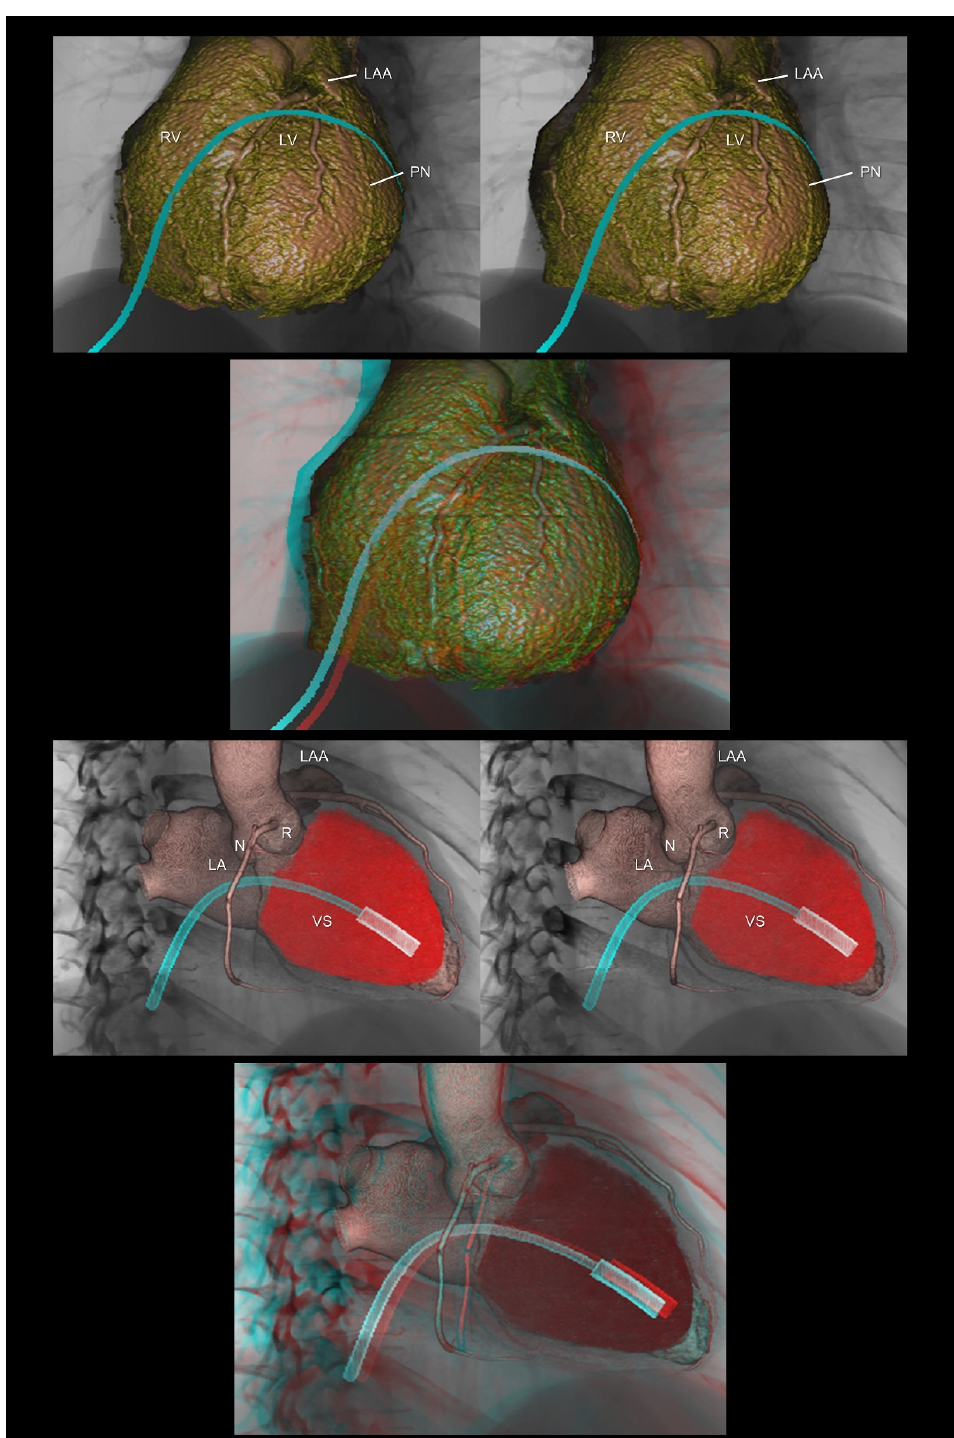
Figure 10. The upper panels demonstrate virtual epicardial ablation using the anterior approach via a subxiphoid access. The lower panels show a virtual delivery system of the leadless pacemaker. The first and second panels are aligned for cross ‐ eyed viewing. The third panel is the anaglyph. To see the anaglyph, anaglyphic glasses (red/cyan) are required. LA, left atrium; LAA, left atrial appendage; LV, left ventricle; N, noncoronary aortic sinus; R, right coronary aortic sinus; RV, right ventricle; PN, phrenic nerve; VS, ventricular septum.